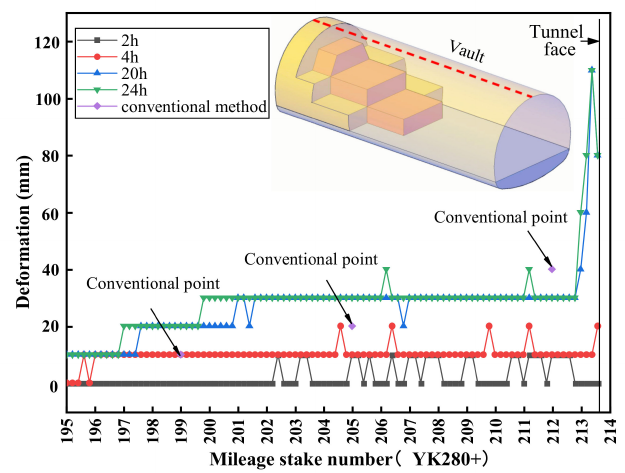
Figure 14. Longitudinal distribution of total deformation of the vault at right line entrance in 24 h.